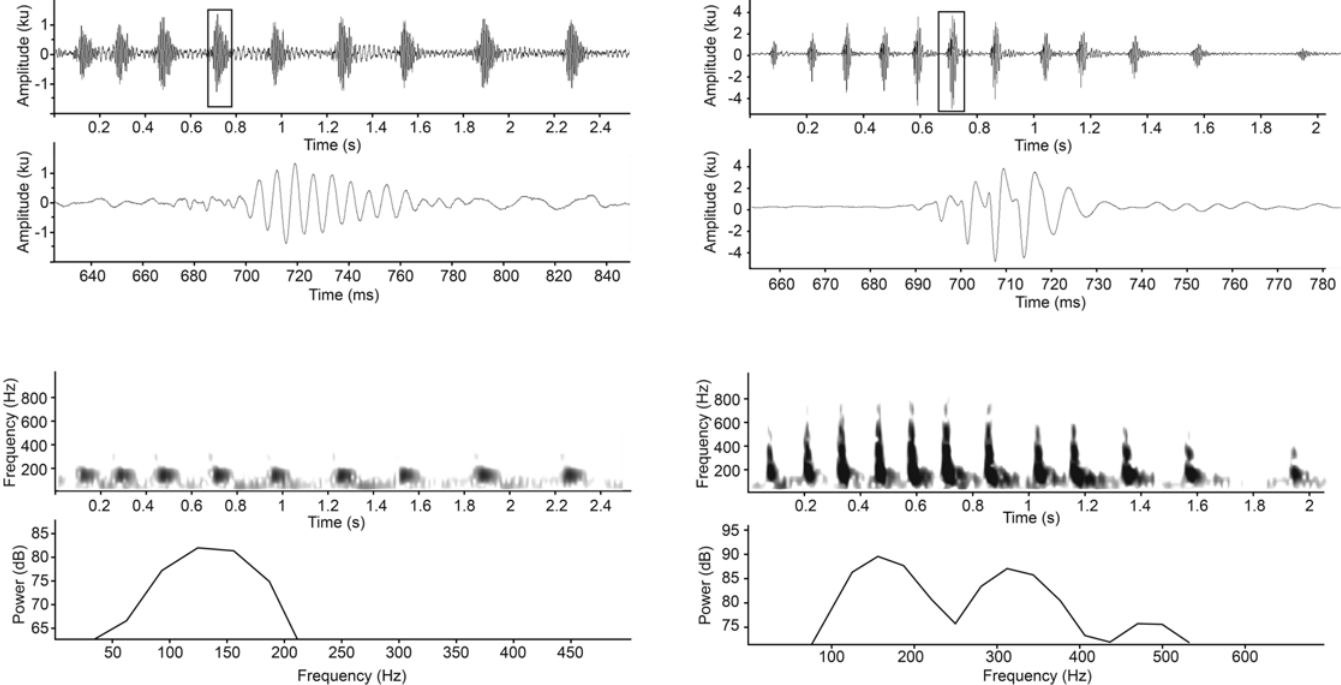
Fig 1. Oscillograms (whole sound and enlarged section), spectrogram and power spectrum (750 point FFT; Hanning window; 64 Hz filter bandwidth) for representative examples of; a) Gru1 sound, b) Gru2 sound.